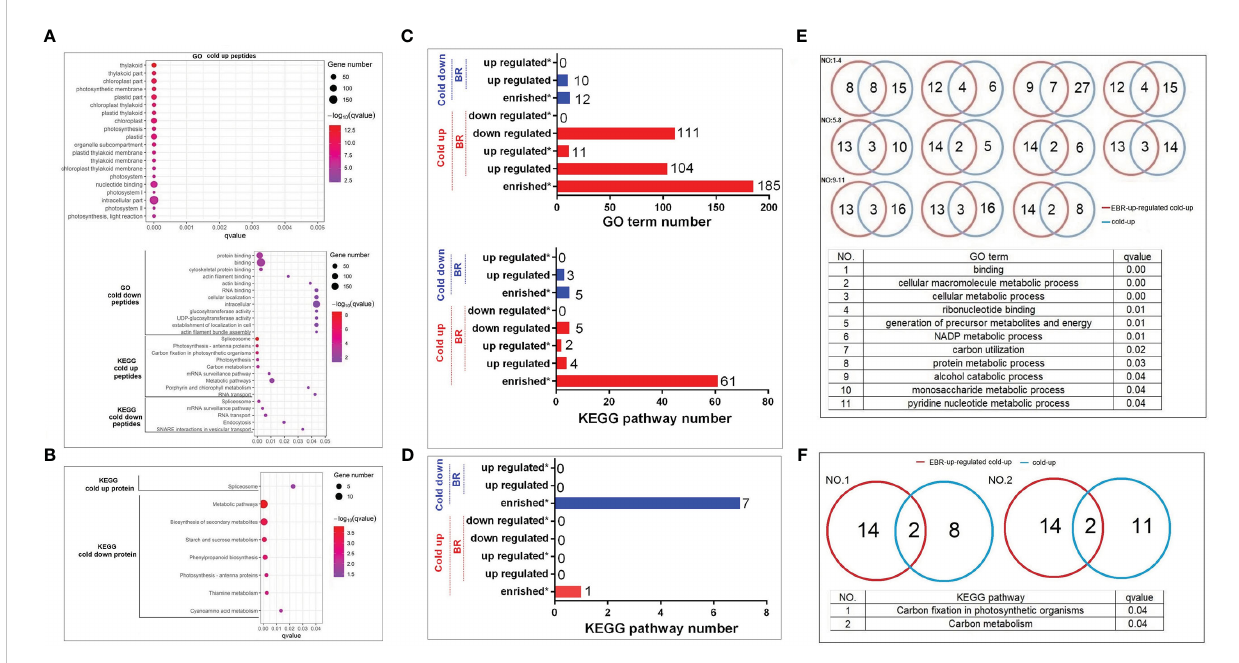
FIGURE 4 The GO and KEGG enrichment analyses of cold-responsive phosphoproteins and proteins. (A, C, E, F) Cold-responsive phosphoproteins; (B, D) cold-responsive